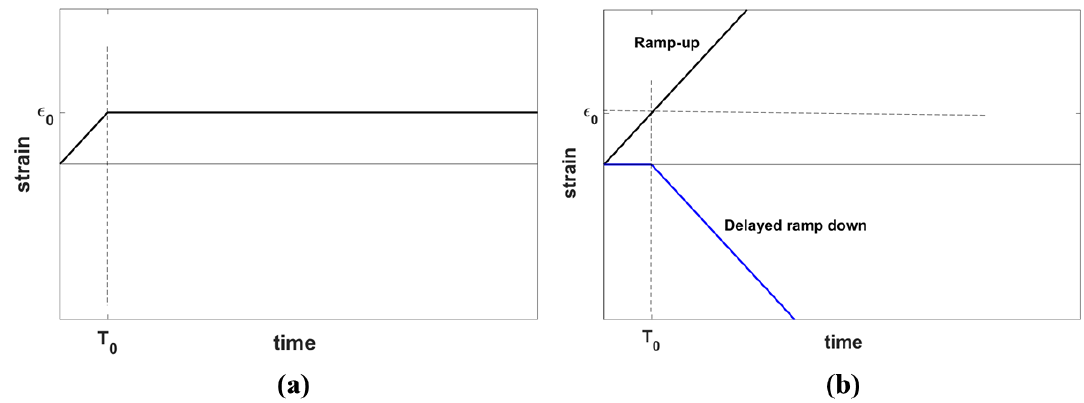
Figure 2. ( a ) A ramp-plus-hold strain function representing the experimental step strain applied in practice for the stress relaxation test and ( b ) an equivalent representation of the strain function in ( a ) composed of a ramp-up strain function plus a delayed ramp-down strain function. The parameter ε 0 indicates the hold strain and T 0 shows the ramp duration.